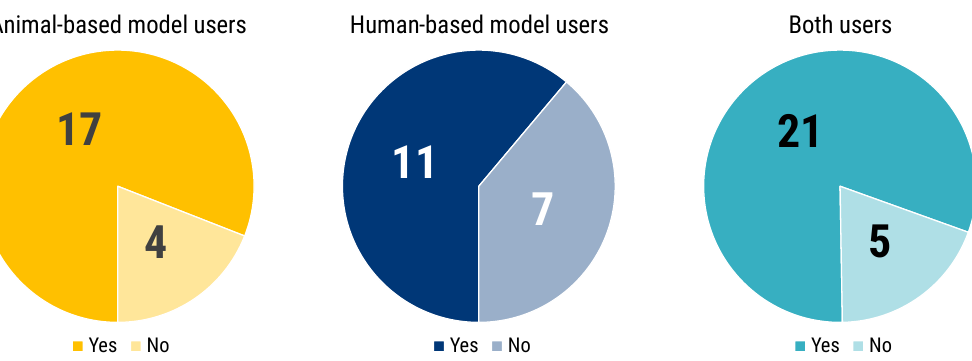
Figure 6. Participants answered the following question “Did you have any direct experience?”. This chart is linked to the previous question (see Figure 5). The pie charts show the number of respondents answering “Yes” (blue) and “No” (red) segmented by researchers’ use of animal- (shades of yellow) or human-based (shades of blue) or both models (shades of turquoise).